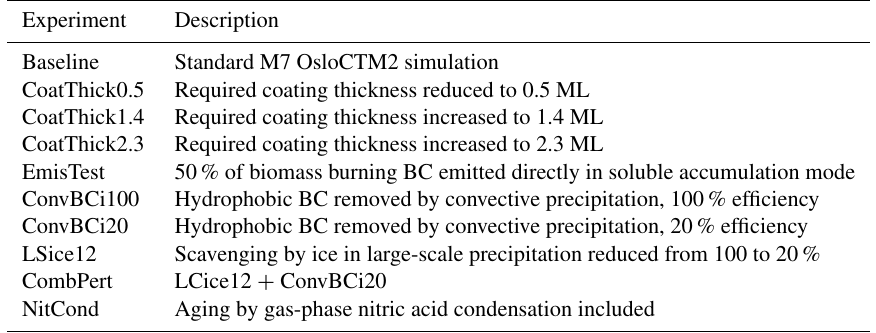
Table 1. Summary and description OsloCTM2–M7 experiments performed in this study.